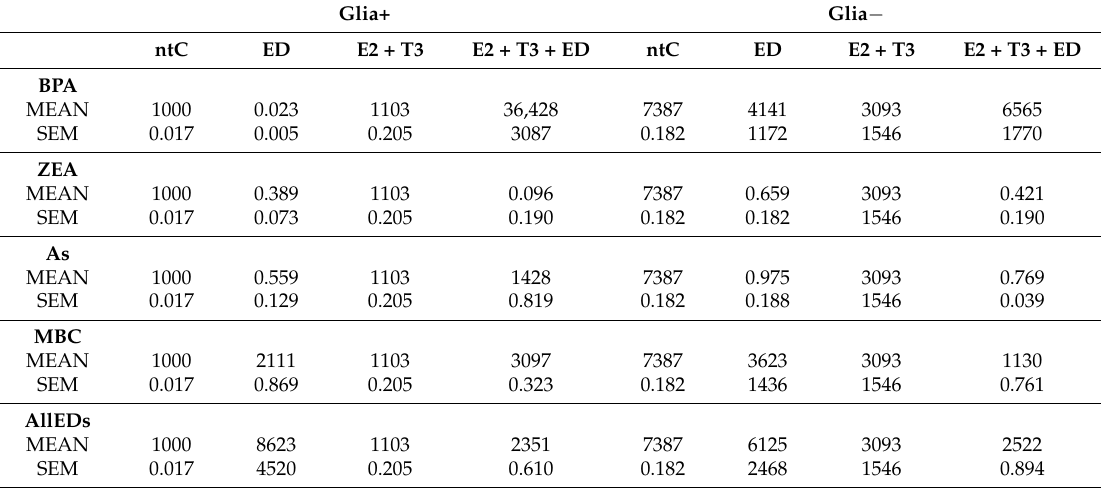
Table A1. Fold difference values (mean and SEM) from the different ED experimental